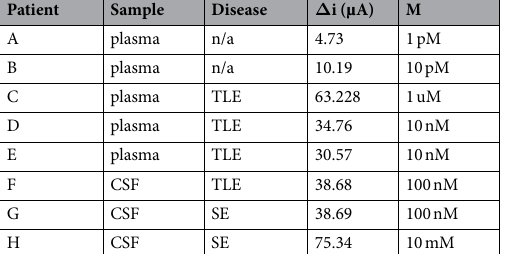
Table 2. Summary of the electrocatalytic response for each of the patient samples. Key: CSF, cerebrospinal fluid; TLE, temporal lobe epilepsy; SE, status epilepticus; M,